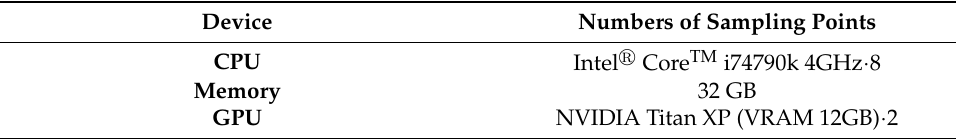
Table 2. Information of hardware.